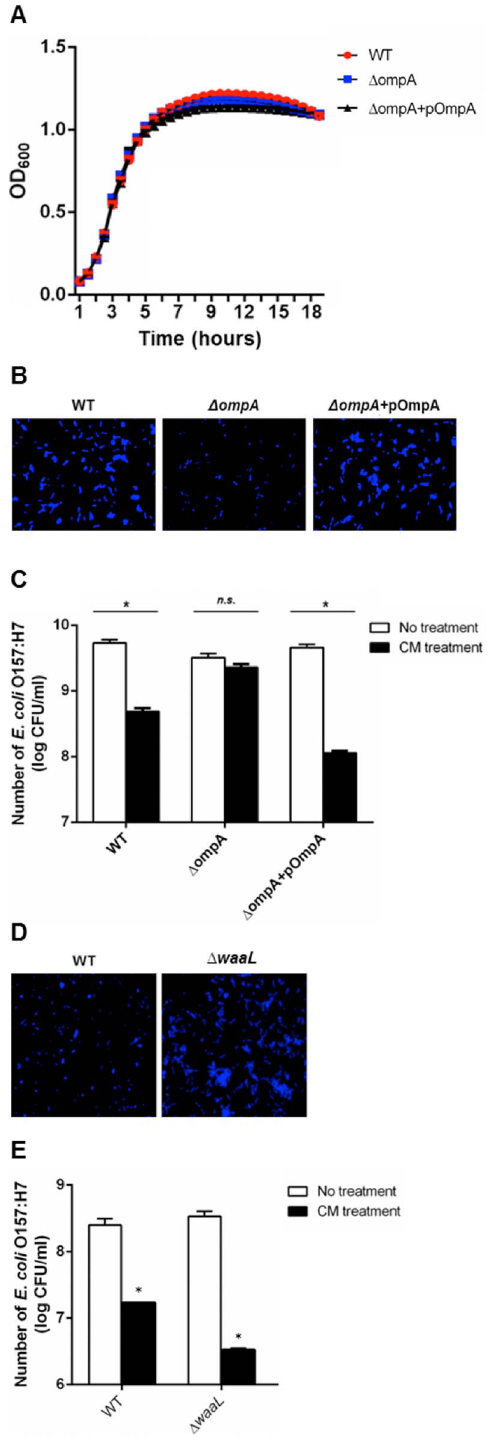
Figure 3. CM interaction with E.coli O157:H7 via OmpA and LPS is linked to antimicrobial activity. (A) Growth curve of wild-type (circle), D ompA (KCJ806), and D ompA + pOmpA (KCJ1449). (B) In vitro CM binding assay of the D ompA strain. pOmpA complements the loss of binding activity of the D ompA strain. Bound cells were stained with DAPI and enumerated with fluorescence microscopy. (C) Binding of CM to OmpA is linked to the antimicrobial activity of CM. Antibacterial activity of CM was attenuated in D ompA, but restored with pOmpA. Strains used for antimicrobial assay were: wild-type (EDL933), D ompA